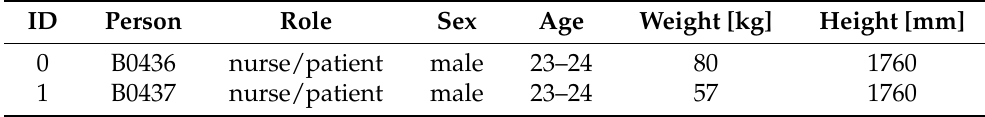
Table 2. Biometric data of the registered participants.